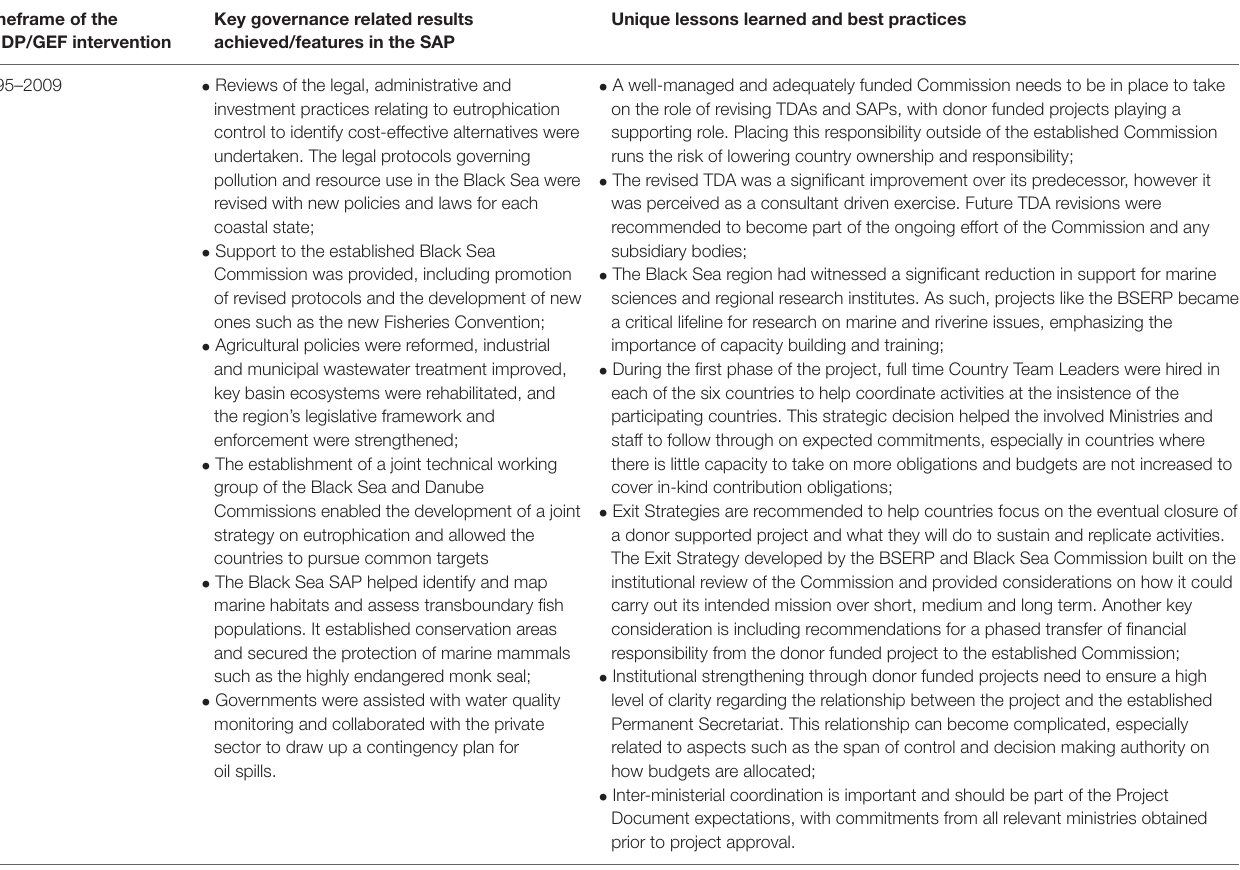
TABLE 1 | Highlighted results of the TDA-SAP process and LME Approach in the Black Sea as well as unique lessons learned from the intervention (United Nations Development Programme, 2007b; Fox and Buijs, 2008). Timeframe of the Key governance related results Unique lessons learned and best UNDP/GEF intervention achieved/features in the SAP